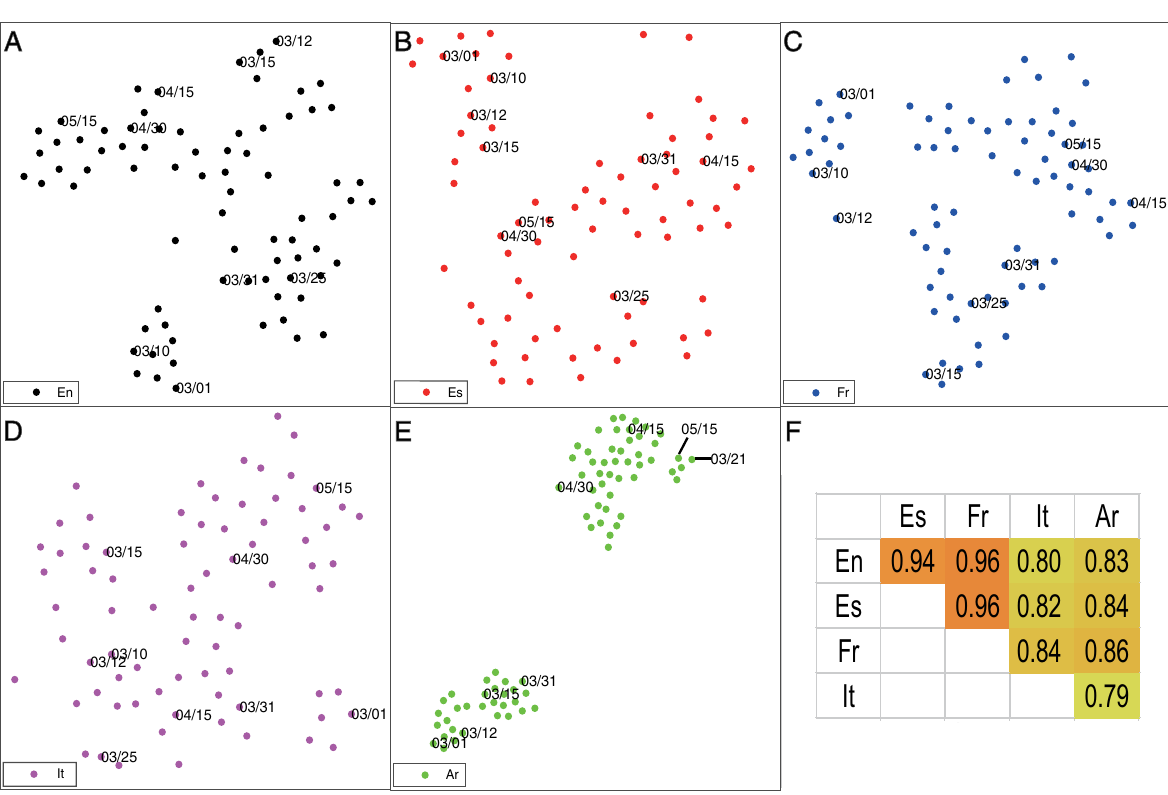
Fig. 4 Visualization of daily sentiment compositions. A – E Visualization by principal component analysis and then t-distributed stochastic neighbor embedding (t-SNE) for daily sentiments in English (En), Spanish (Es), French (Fr), Italian (It), and Arabic (Ar) (each point presents the sentiment of one day). Sampled points were annotated with the corresponding dates. F The correlation coef fi cients of the average daily sentiment distribution among fi ve languages (English, Spanish, French, Italian, and Arabic) analyzed on